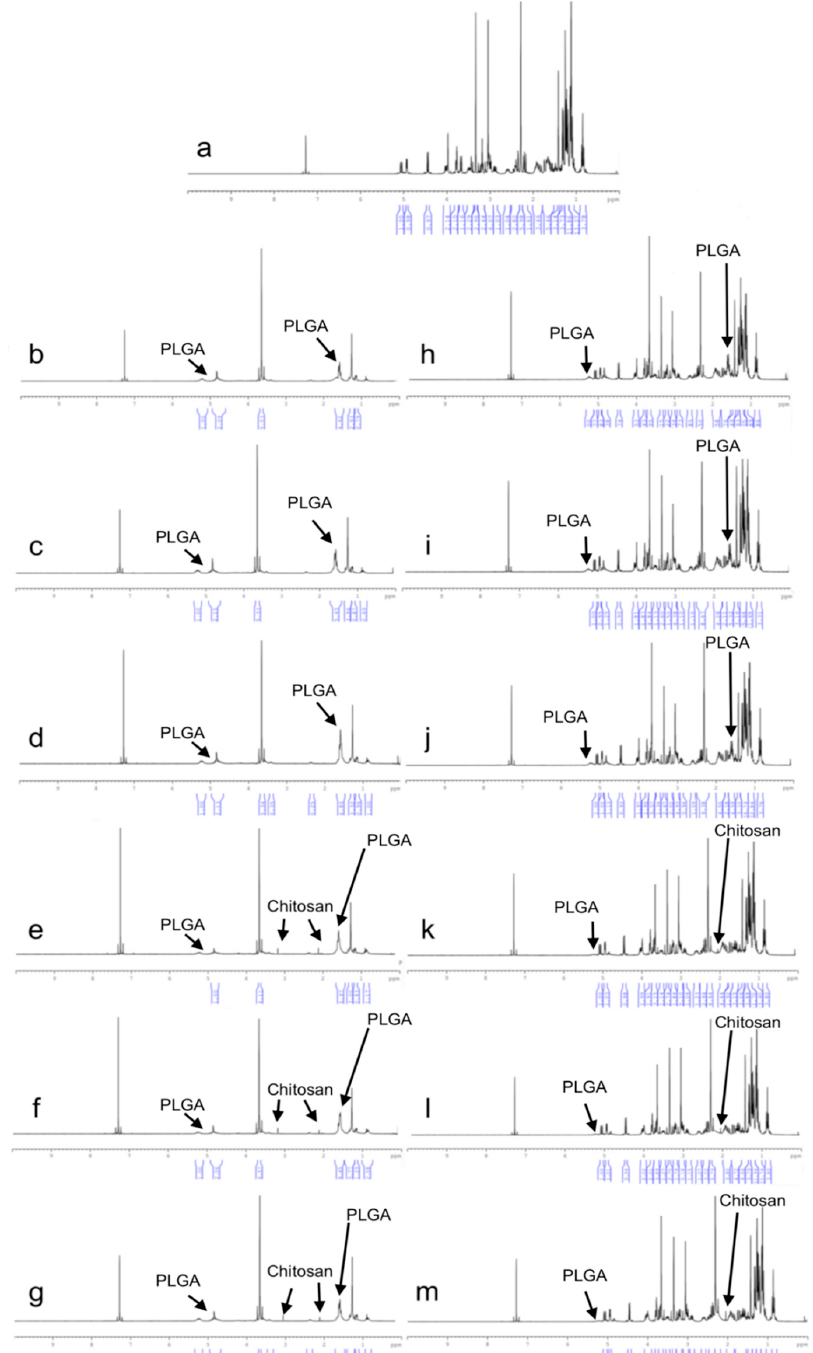
Figure 7. 1 H-NMR spectrum of CLR and NPs, ( a ) CLR, ( b ) 502H-Blank, ( c ) 503H-Blank, ( d ) 504H-Blank, ( e ) CS-502H-Blank, ( f ) CS-503H-Blank, ( g ) CS-504H-Blank, ( h ) 502H, ( i ) 503H, ( j ) 504H, ( k ) CS-502H, ( l ) CS-503H, ( m ) CS-504H.